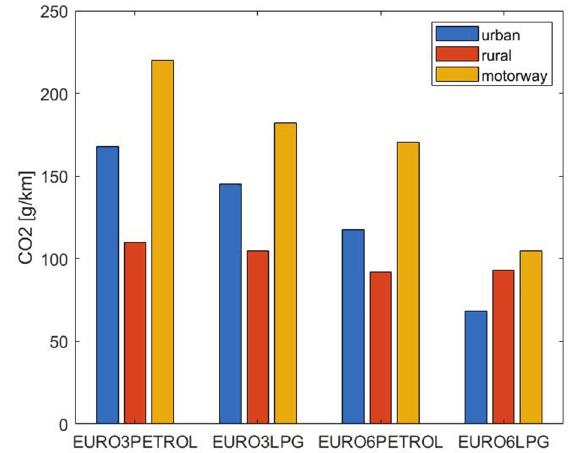
Fig, 13. Correlation between NO x emission intensity and velocity and acceleration of Euro 6 petrol fuelled vehicle